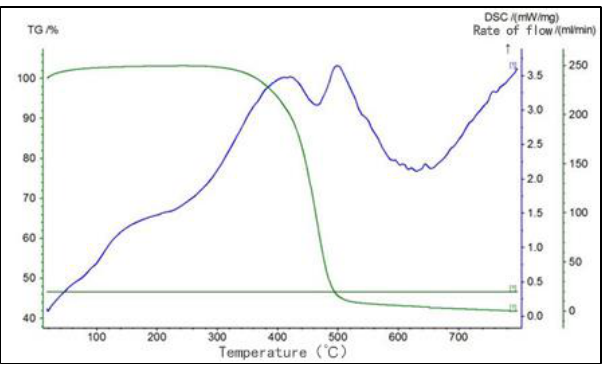
Figure 2. TG – DSC curve of 70 base asphalt.